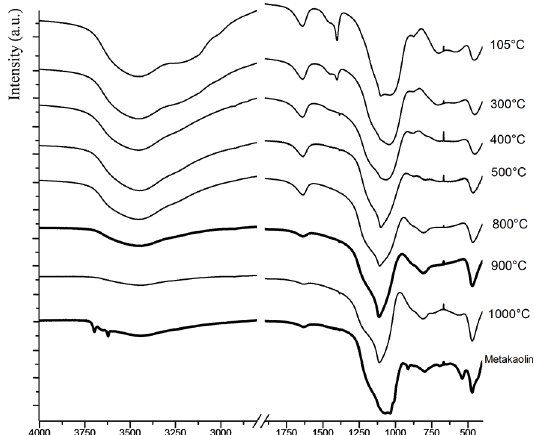
Figure 3. FTIR spectra of powders heat treated at different temperatures and natural metakaolin.